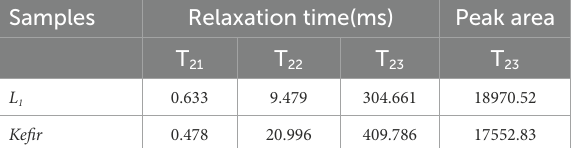
TABLE 3 LF-NMR data of Kefir and L 1 .